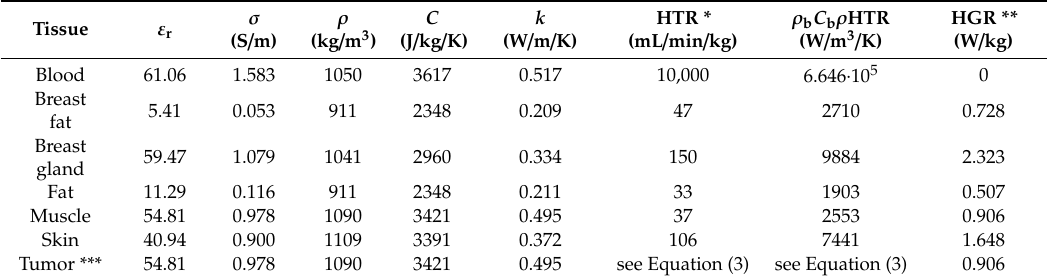
Table 1. Dielectric and thermal tissue parameters employed in a female breast phantom for dipole antennas working at a frequency f = 1 GHz [61].